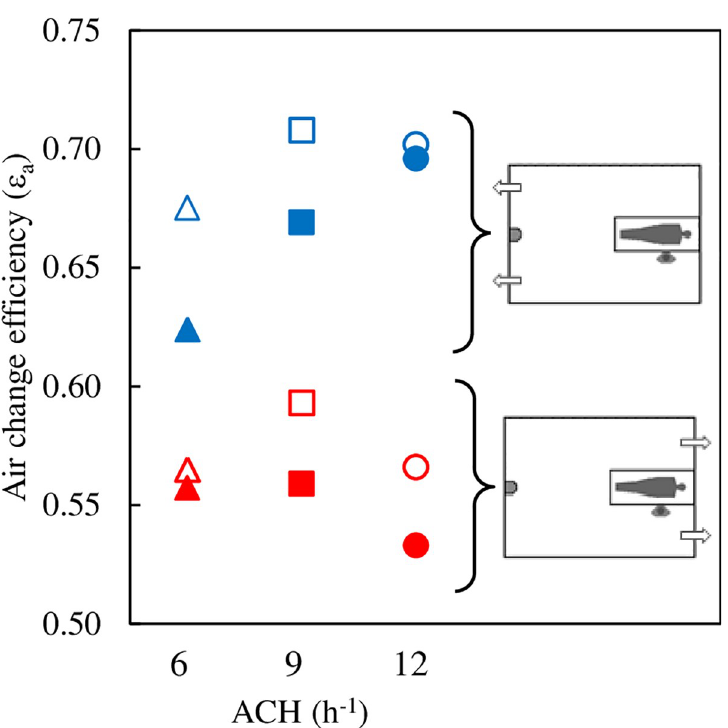
Fig 4. Air change efficiency index. Blue symbols: exhaust openings on the wall of the DD. Red symbols: exhaust openings on the wall of the bed. Full symbols: radiant wall in front of the HCW. Empty symbols: radiant wall behind the